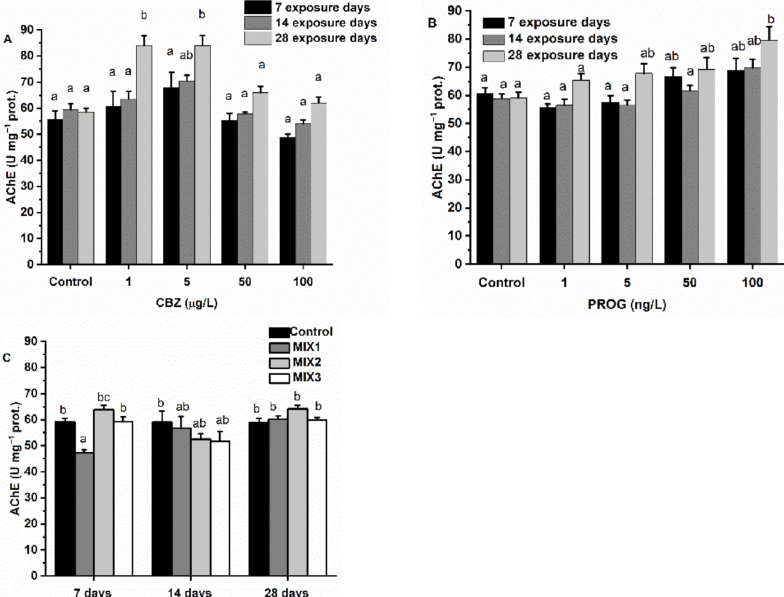
Figure 2. Changes in AChE activity in the brain of Danio rerio exposed to ( A ) CBZ, ( B ) P4, and ( C ) binary mixtures of CBZ and P4 for 7, 14, and 28 days. Data are expressed as mean ± standard deviation of fifteen replicates ( n = 15). Different letters indicate significant differences at p < 0.05 after a two-way ANOVA followed by Tukey’s post hoc